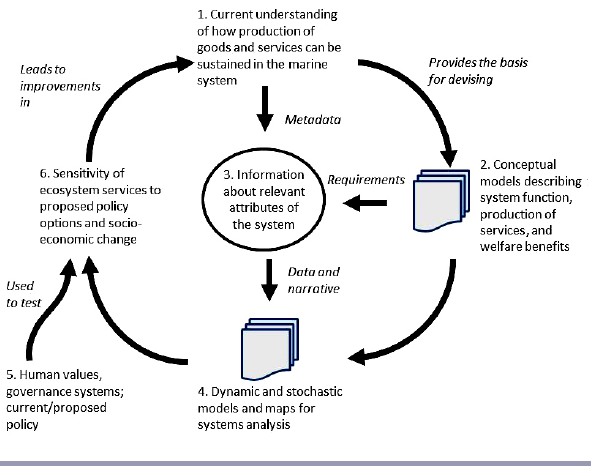
Fig. 1 . Approach used for improving understanding of the social- ecological